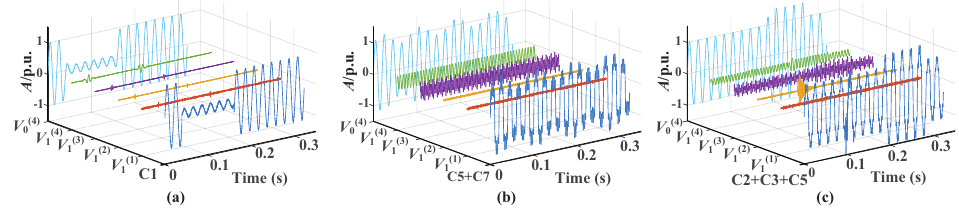
Figure 6. The decomposition results of TQWT with parameter selection for three PQ disturbance signals: ( a ) sag (C1); ( b ) harmonic+flicker (C5+C7); and ( c ) swell+oscillation transient+harmonic (C2+C3+C5).